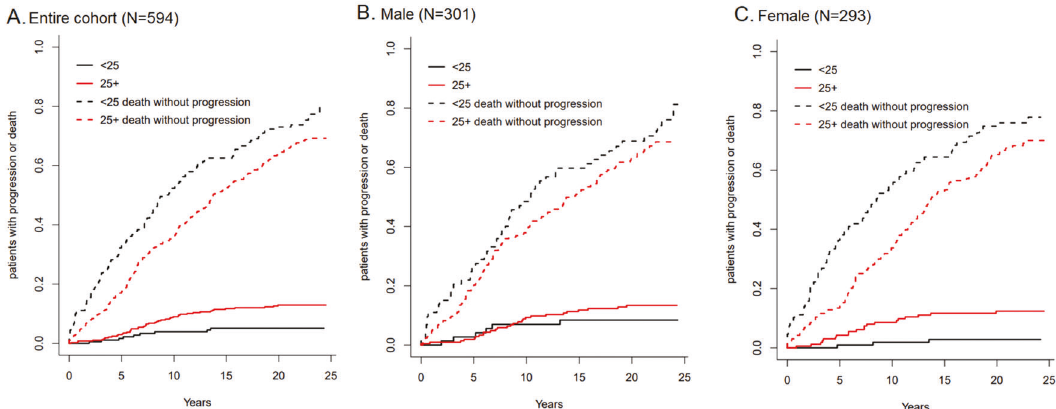
Fig. 1 Cumulative Incidence of progression of MGUS by BMI, with death accounted for as a competing risk. A . Entire cohort ( N = 594); B . Males ( N = 301); C . Females ( N = 293). BMI strati fi ed by <25 (black solid line), <25 death without progression (black dashed line), 25 + (red solid line), and 25 + death without progression (red dashed